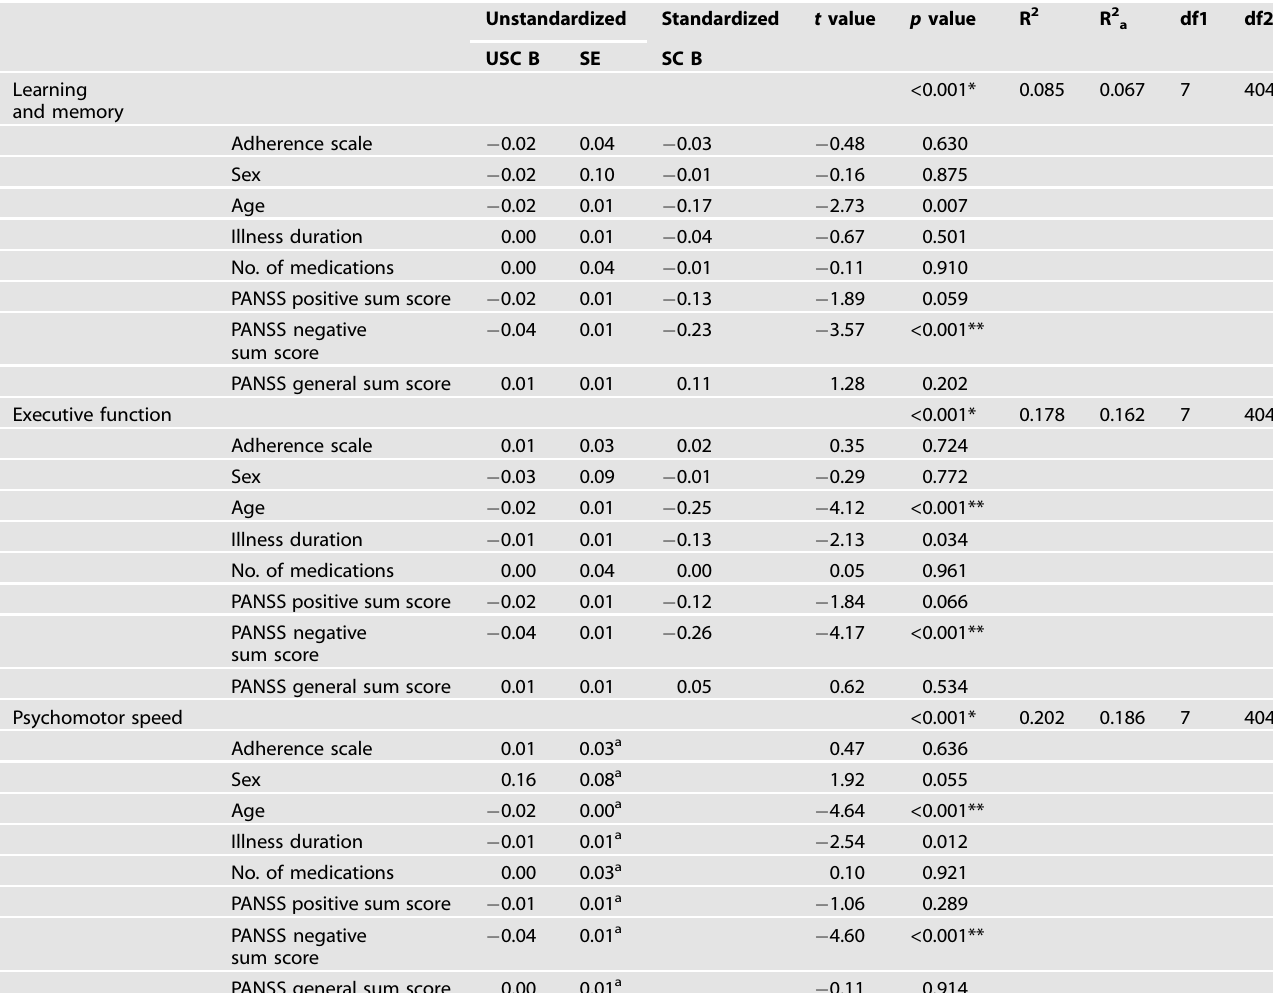
Table 3. Multiple linear regression analyses in the group of patients with schizophrenia-spectrum disorder with cognitive performance as the dependent variable and adherence behavior, sex, age, duration of illness, number of medications, and Positive and Negative Syndrome Scale scores as the predictors. Group of patients with schizophrenia-spectrum